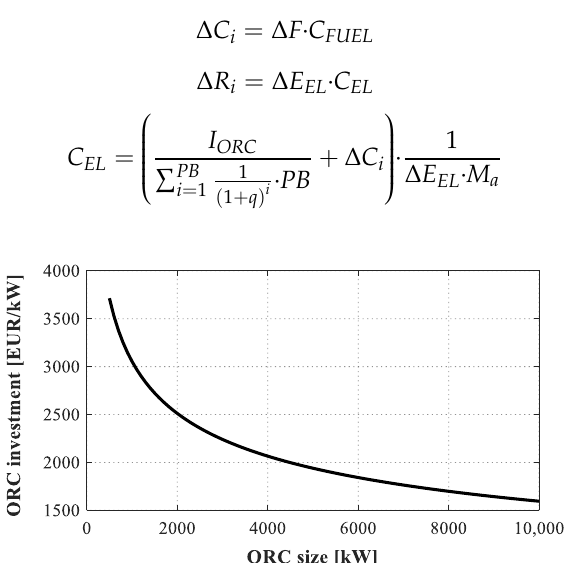
Figure 12. ORC specific investment cost as a function of plant size [23].